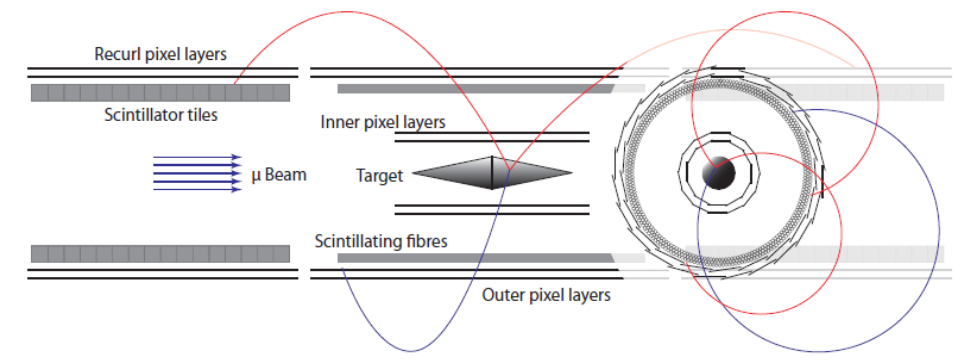
Figure 4: Schematic view of the Mu3e detector in phase I configuration (side view and cross section) showing all detector’s components: the target, the inner silicon pixels, the scintillating fiber tracker, and the outer silicon pixels in the central region, and the scintillating tiles and the silicon pixels in the recurl stations. Two additional recurl stations will be added in phase II. The total length of the full detector is around 180 cm and the diameter is about 15 cm. The detector is inserted into a 100 cm diameter and 300 cm long superconducting solenoid providing a uniform magnetic field of 1